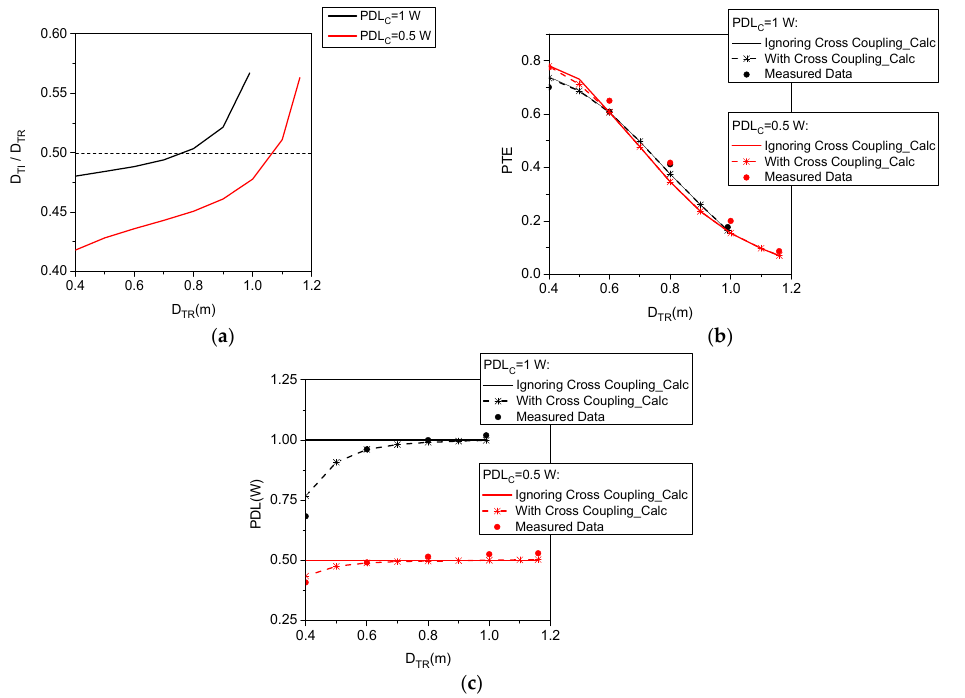
Figure 14. Energy transfer of obtaining predetermined constant PDL at maximum PTE at 1.96 MHz when PDL C = 1 W and 0.5 W: ( a ) Ratio of optimal D TI to D TR vs. D TR ; ( b ) Comparison between the calculated and measured values of PTE; and ( c ) Comparison between the calculated and measured values of PDL.